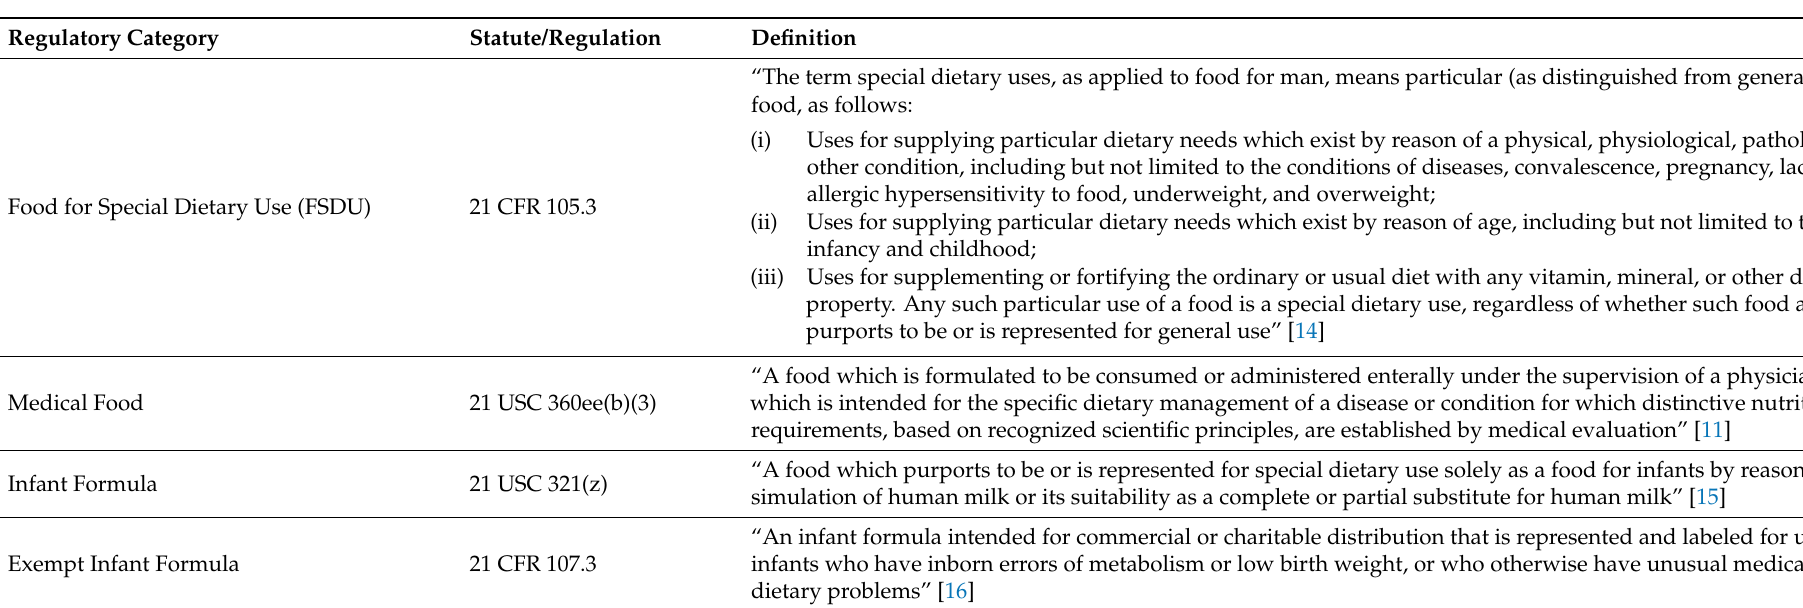
Table 1. Regulatory definitions for specialized product categories in the United